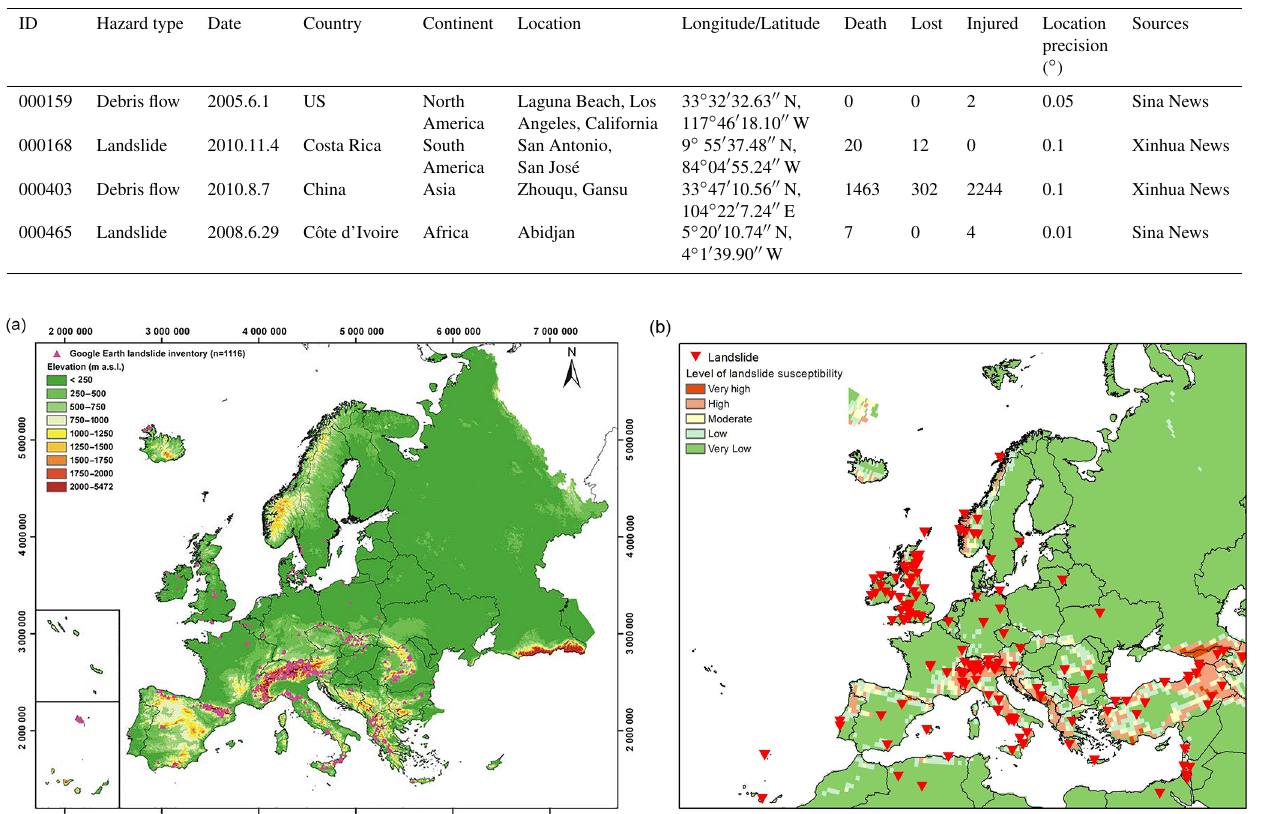
Table 3. Example of landslide inventory in World Geological Hazard Inventory created by ADREM, BNU.